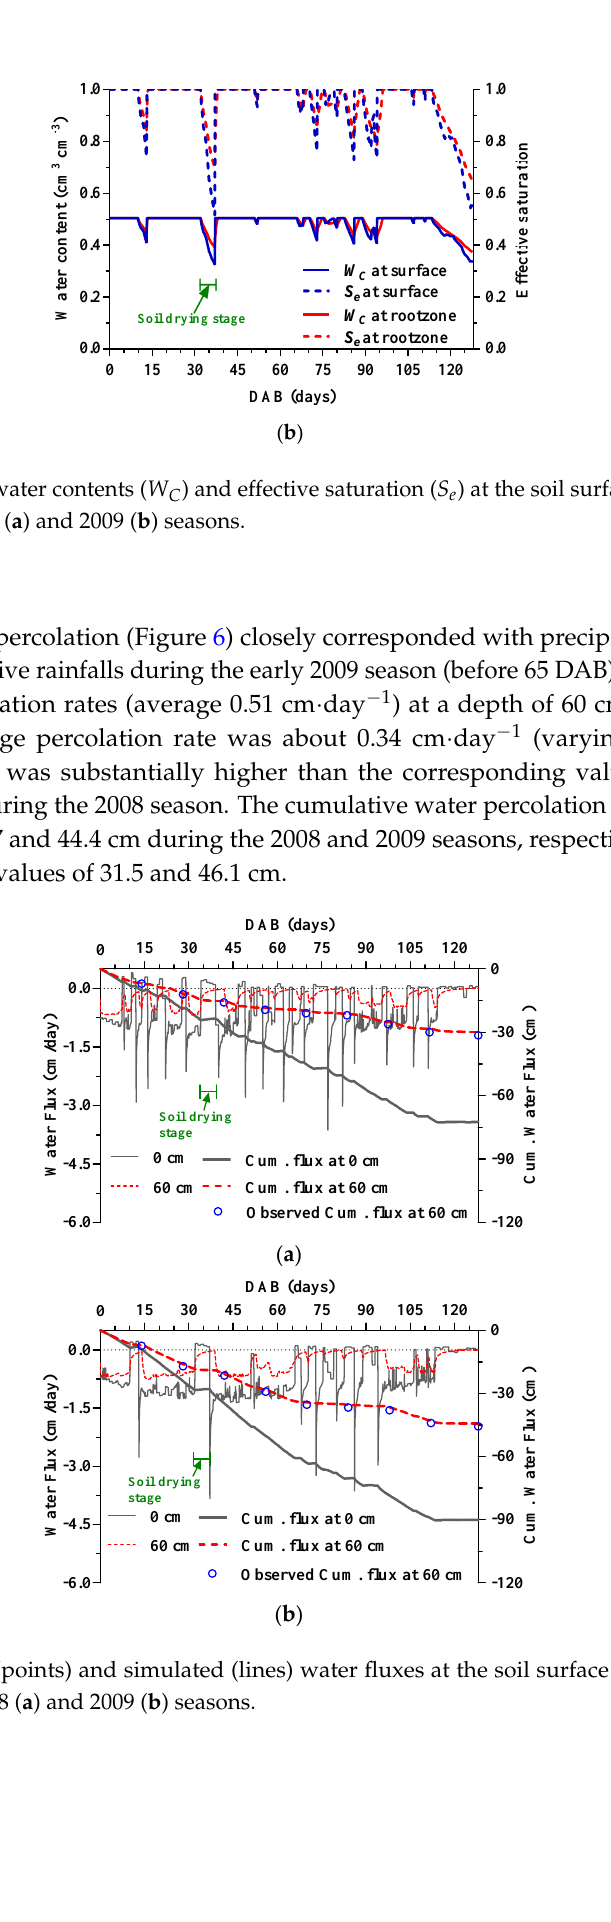
Figure 6. Observed (points) and simulated (lines) water fluxes at the soil surface and at a depth of 60 cm during the 2008 ( a ) and 2009 ( b ) seasons.